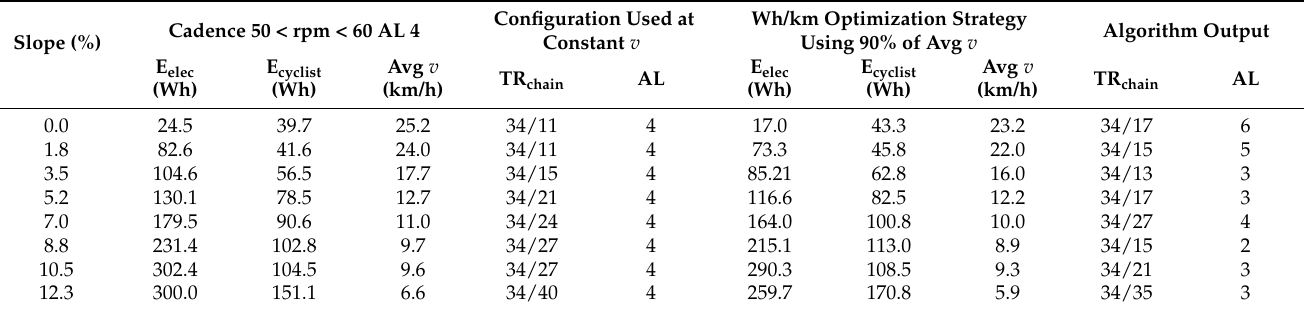
Table 6. Performance of strategies two and one (speed restriction modified) under e-bike and human power (E stands for energy, v stands for speed, TR chain stands for chain transmission ratio and AL stands for assistance level). Slope (%)